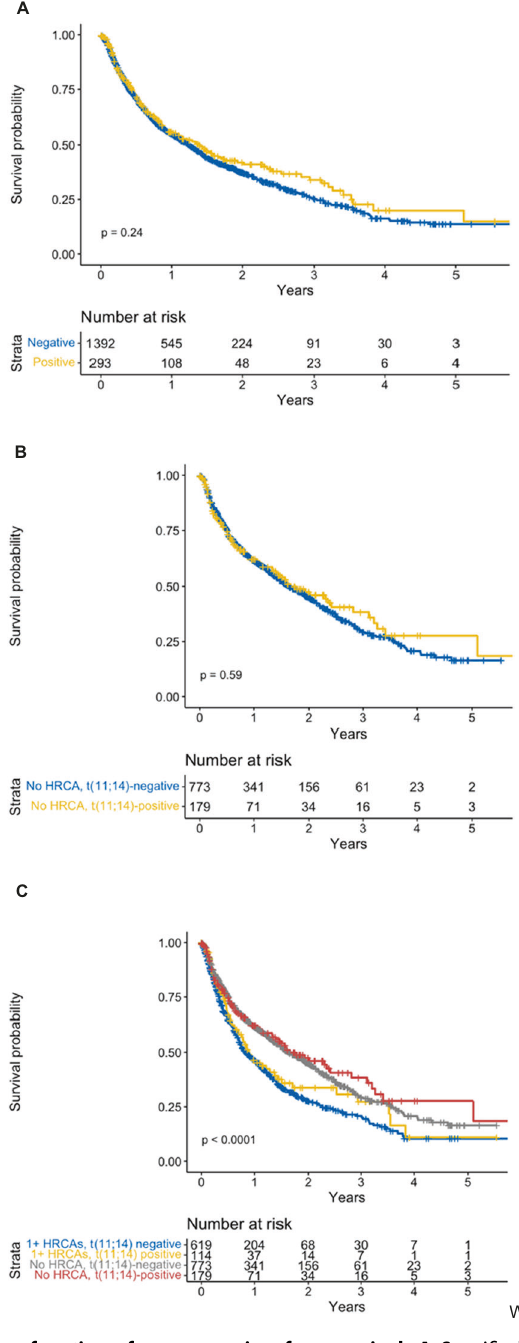
Fig. 1 Kaplan – Meier describing survivor functions for progression free survival. A Strati fi ed by t (11;14) negative or t(11;14) positive. B Strati fi ed by t (11;14) negative with no other high risk cytogenetics and t (11;14) positive with no other high risk features. C Strati fi ed into four groups based on the presence or absence of high risk cytogenetic abnormalities and the presence or absence of t